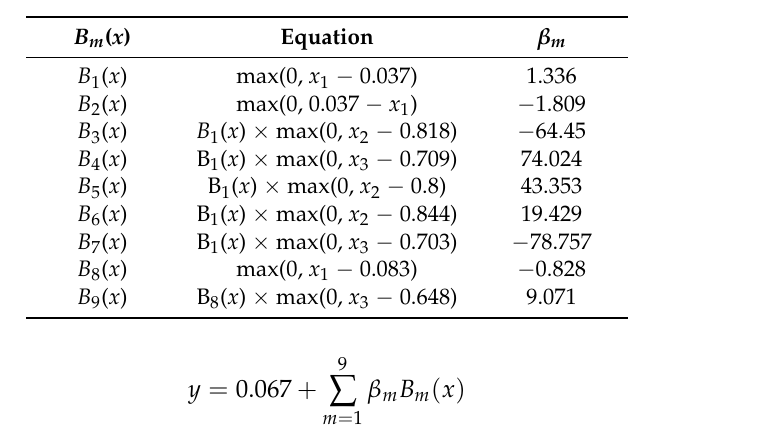
Table 4. Basis functions of y and corresponding coefficients.